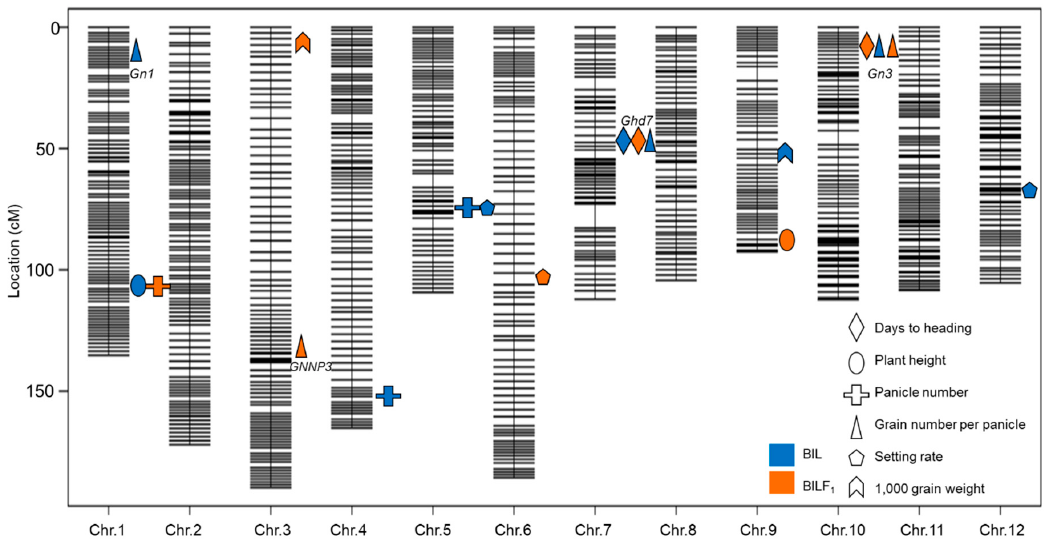
Figure 4. The position of quantitative trait locuses (QTLs) for yield-related traits and heterosis QTLs in BILs and BILF 1 s. Different colors represent the QTLs detected in BILs and BILF 1 s.